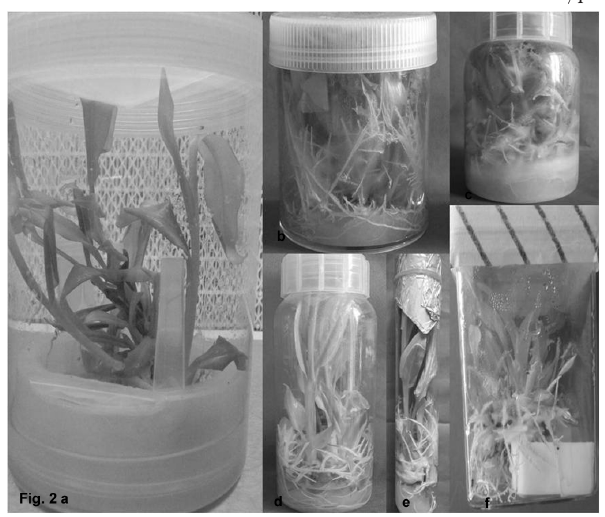
Fig. 2. Effect of different culture vessels on microrhizomes pro- duction in (a) Growtek, (b) Phytajar, (c) Saveer culture bottle 190 ml, (d) Saveer culture bottle 290 ml, (e) Culture tube and (f)